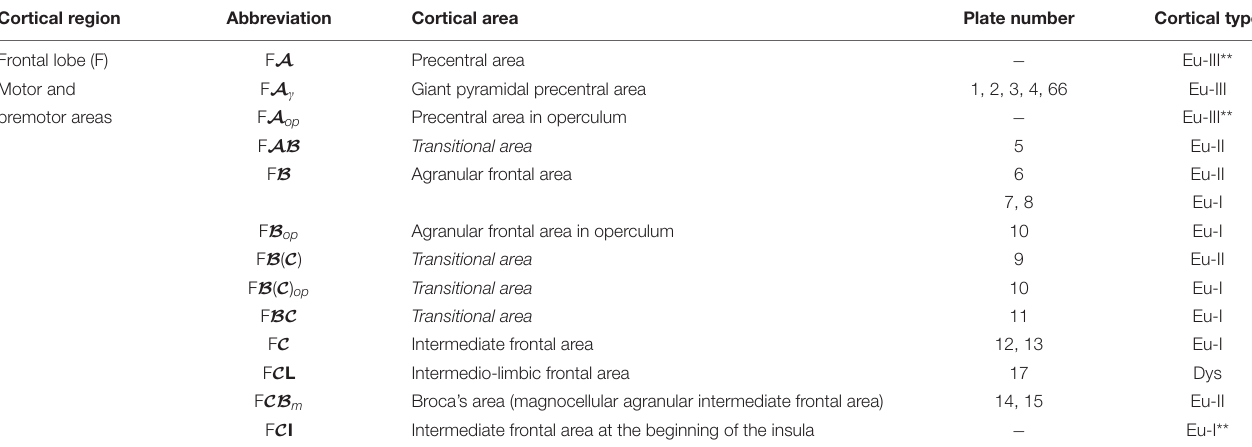
TABLE 4 | Areas in the human cerebral cortex according to von Economo and Koskinas (1925/2008) and their corresponding types: Frontal lobe, premotor and primary motor areas. Cortical